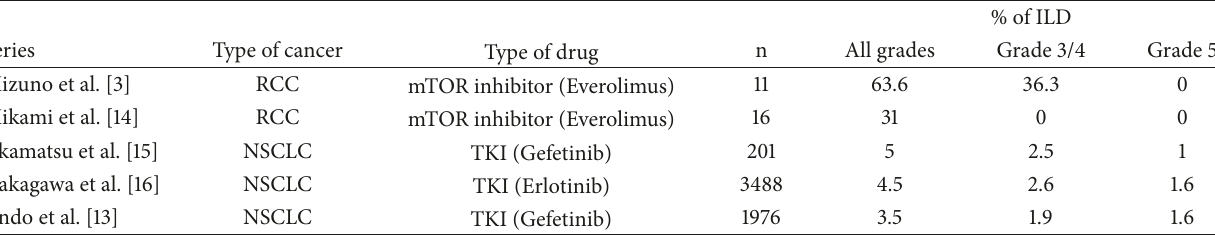
Table 1: Comparison of previous studies regarding interstitial lung disease associated with TKI or mTOR inhibitor in Japanese patients with renal cell carcinoma and lung cancer.